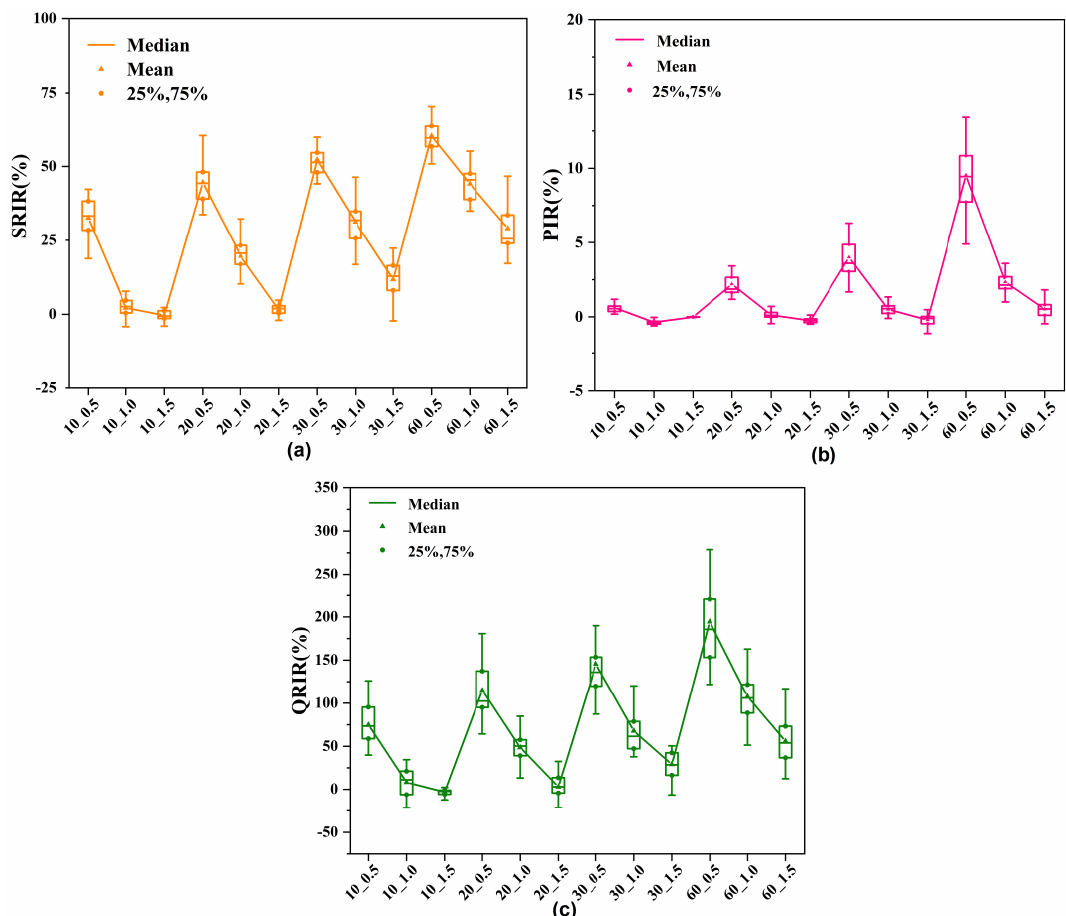
Figure 9. Quartile graph of 𝑆𝑅𝐼𝑅 , 𝑃𝐼𝑅 and 𝑄𝑅𝐼𝑅 for every benchmark problem. ( a ) Quartile graph of 𝑆𝑅𝐼𝑅 at different fault levels. ( b ) Quartile graph of 𝑃𝐼𝑅 at different fault levels. ( c ) Quartile graph of 𝑄𝑅𝐼𝑅 at different fault levels.